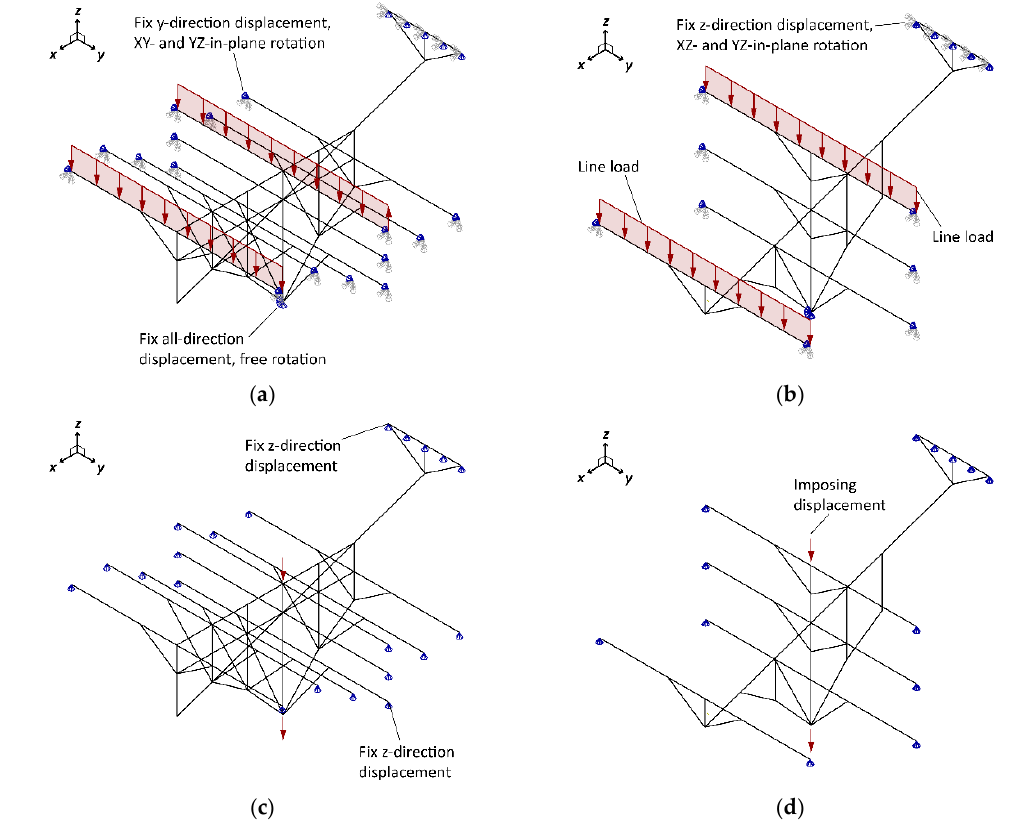
Figure 14. Boundary conditions of the simplified models for the two Dou-gongs: ( a ) Ji-xin-zao, roof load condition; ( b ) Tou-xin-zao, roof load condition; ( c ) Ji-xin-zao, collapse condition; ( d ) Tou-xin-zao, collapse condition.